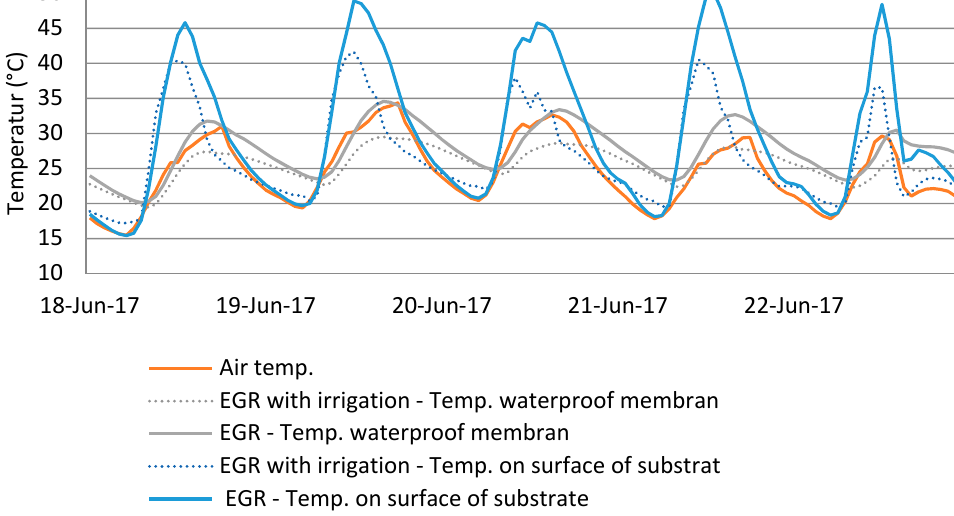
Figure 10. Temperature measurements of 10 cm deep irrigated and conventional EGRs at the ufaFabrik in Berlin (red = air temperature, green dotted line = temperature at the waterproof membrane with irrigation, green = temperature at the waterproof membrane without irrigation, blue dotted line = temperature at the surface of the vegetation with irrigation, blue = temperature at the surface of the vegetation without irrigation).